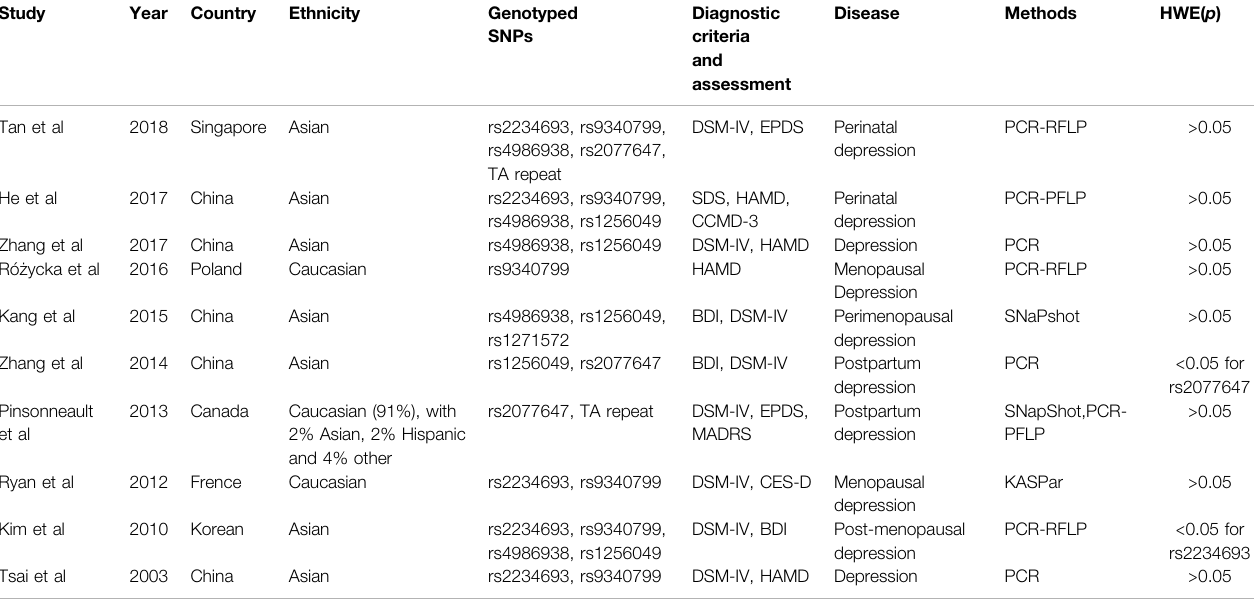
TABLE 2 | Characteristics of studies investigating polymorphisms of ER α and ER β in women with depression.